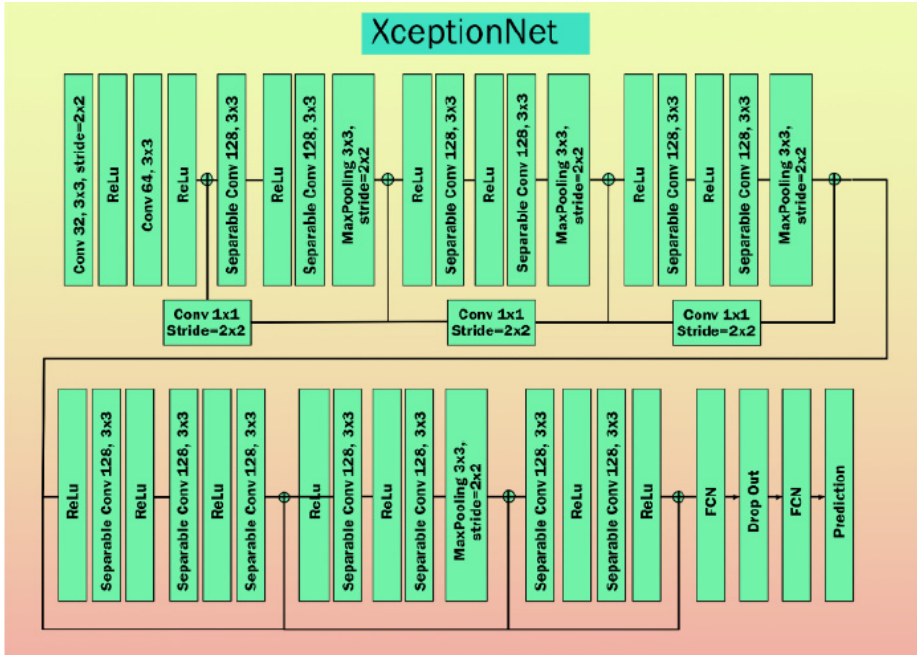
Figure A4. The general structure of XceptionNet architecture